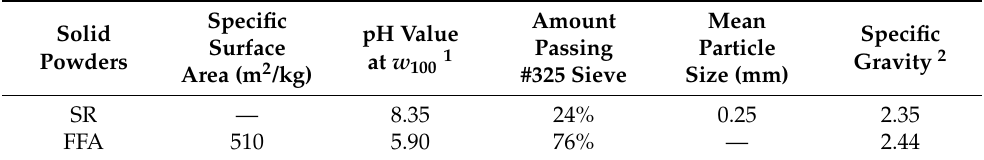
Table 2. Physical indexes of raw material SR and